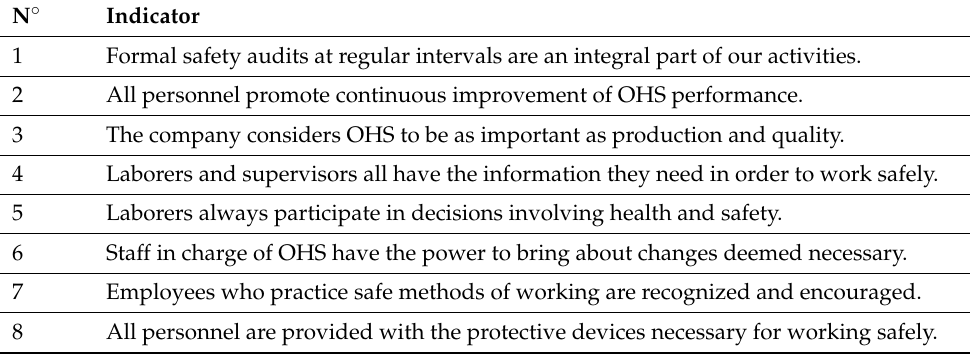
Table 4. Indicators used in the OPM tool